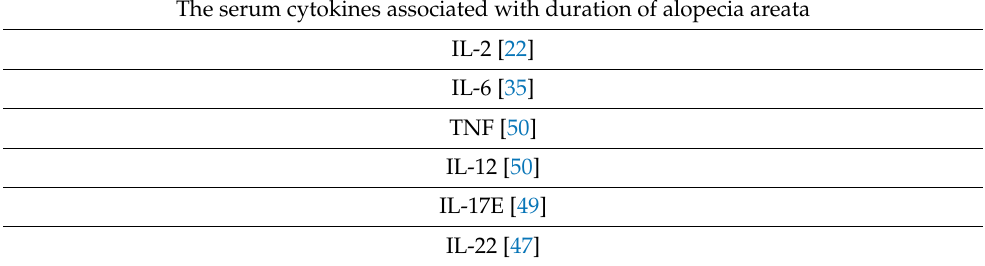
Table 5. The serum cytokines associated with severity of alopecia areata. The serum cytokines associated with duration of alopecia